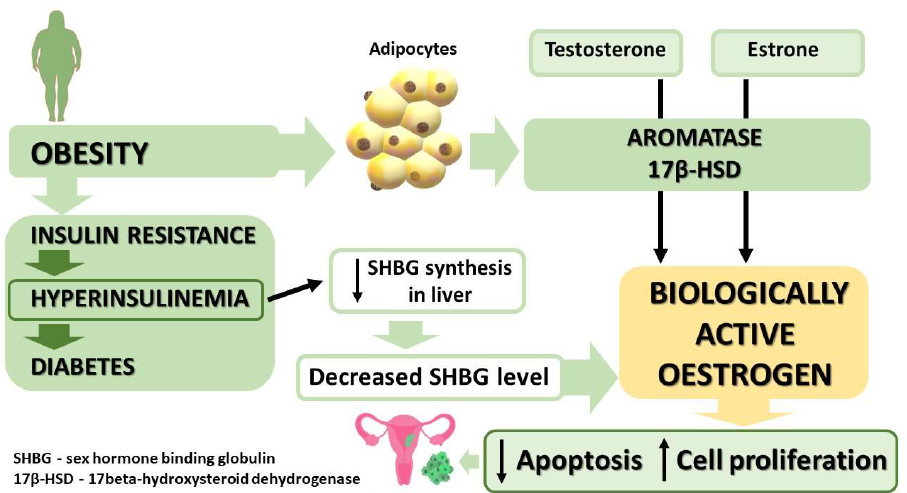
Figure 3. Mechanism of oncogenesis as mediated by active estrogen in hyperinsulinemia. ↑ increased, ↓ decreased